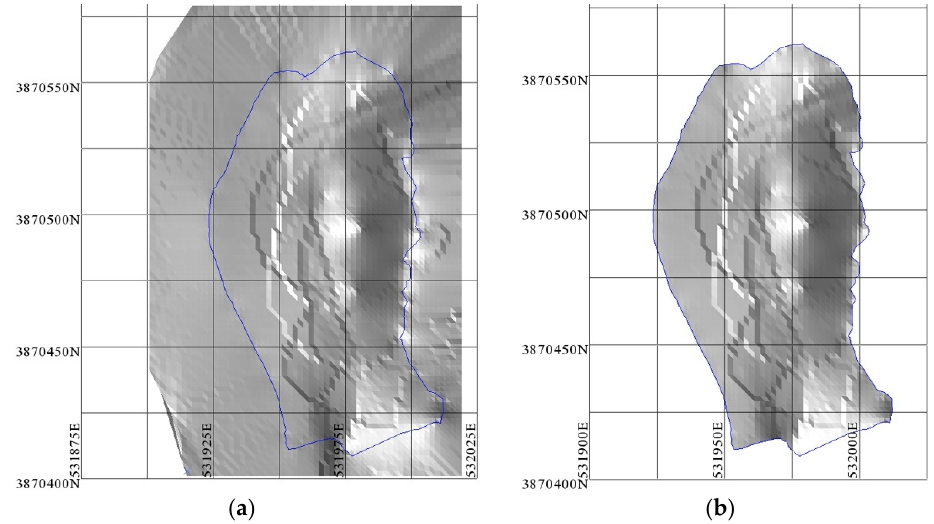
Figure 13. Final stockpile STK1 bottom surface ( a ) before and ( b ) after digitising from UAV data (blue line) boundary is applied.